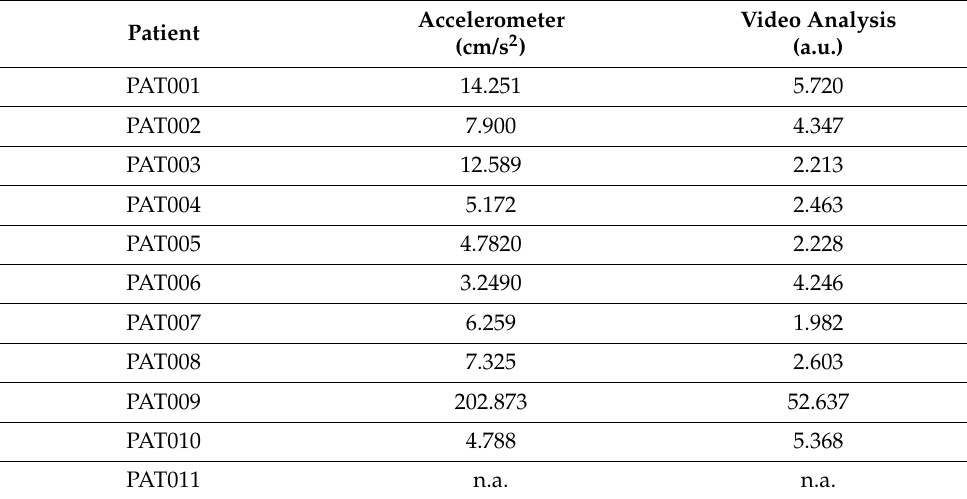
Table 4. Averaged amplitudes from the power spectrum. Accelerometer values from the video analysis are given in arbitrary units (a.u.).